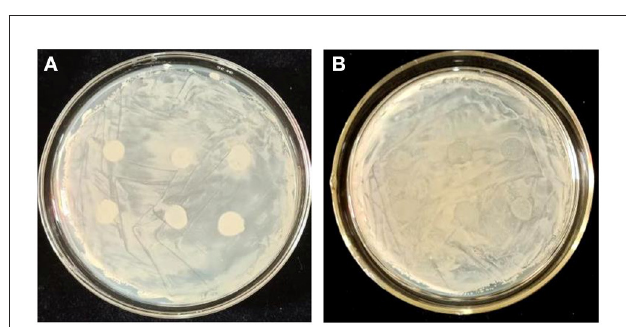
FIGURE5 Determination of strain compatibility. (A) After coating Z-14 bacterial solution on NA medium, JY214 bacterial solution was added dropwise on top; (B) After coating JY214 bacterial solution, Z-14 bacterial solution was added dropwise on